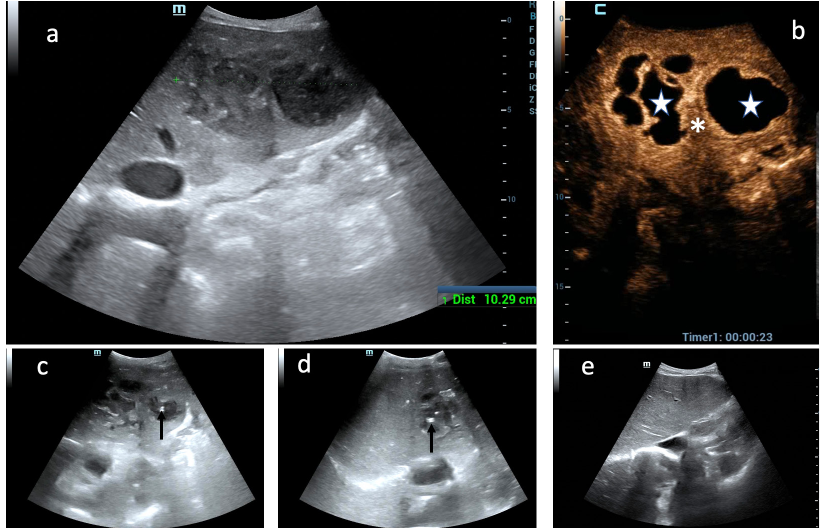
Figure 8. Added value of CEUS to decision-making process for PLA percutaneous treatment. (a) Huge PLA of the left hepatic lobe is displayed as a heterogeneous mass at conventional US; (b) only CEUS definitely shows that two large, not communicating liquified areas (white stars) are separated by a thick septum (white asterisk); (c) the uninoculated medial cavity was aspirated through an 18-g Chiba needle (black arrow point out the needle tip); (d) the multiloculated lateral cavity was drained through a 10-F catheter (black arrow point out the catheter pig-tail); (e) follow-up US scan 4 months after: the left liver lobe in completely